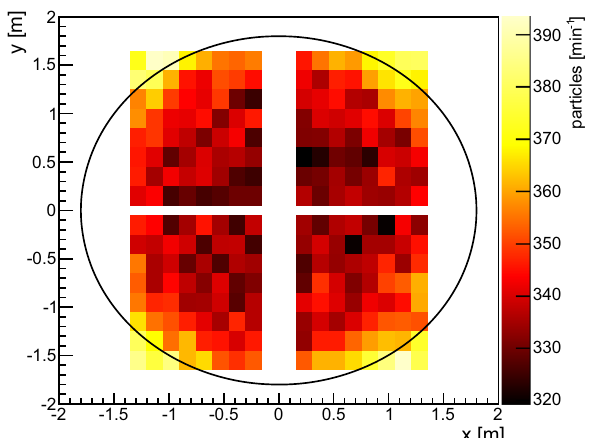
Fig. 6 Number of atmospheric particles in each RPC pad per minute. Result obtained from a dedicated simulation at 1400m a.s.l. (see text for